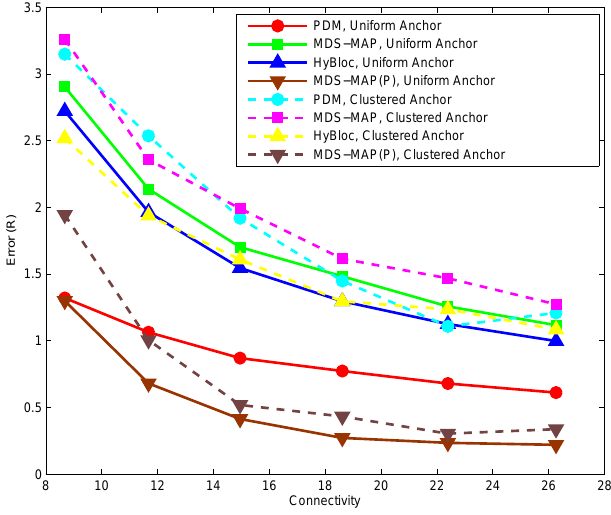
Figure 9 . C-shaped Networks, α =0.10, 5